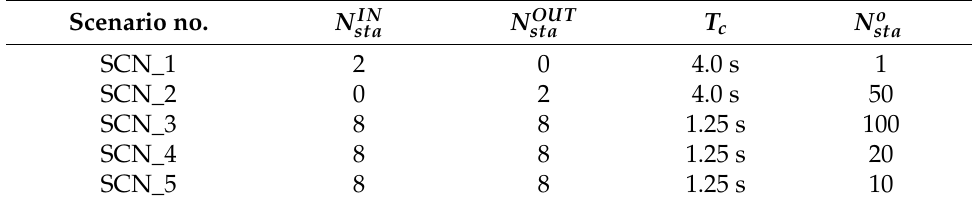
Table 2. Simulation configurations for dynamic network scenarios. Scenario